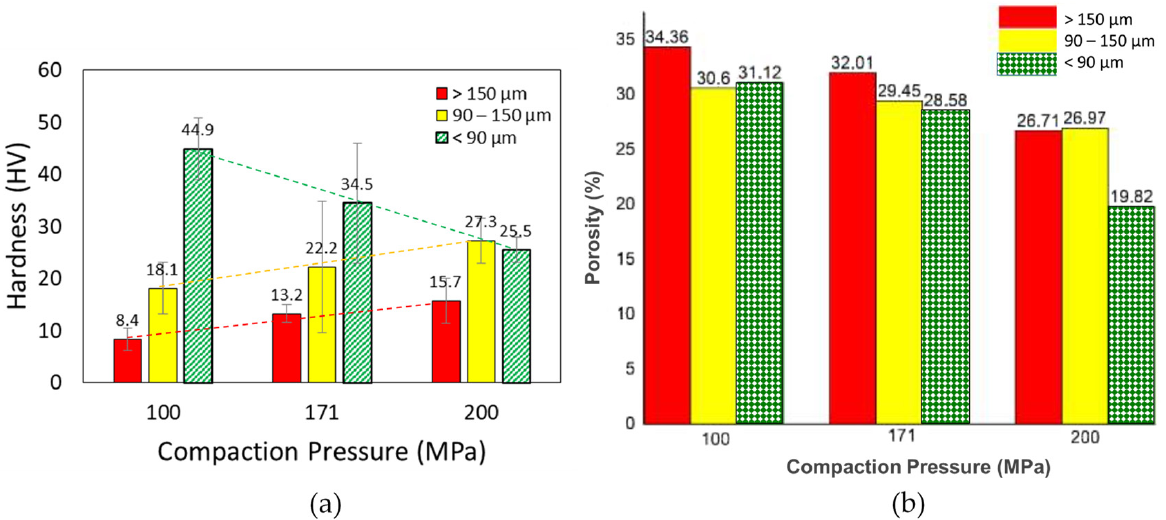
Figure 3. Bar charts of the ( a ) hardness and ( b ) porosity of the hydroxyapatite composite as a function of Al particle size-fraction and compaction pressure. Dashed lines are for a vision guide.